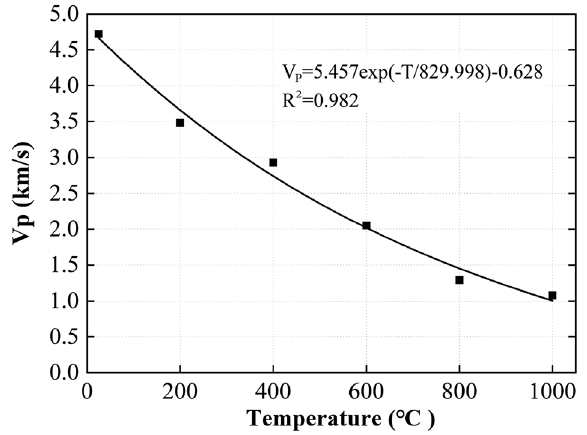
Figure 4. Relationships between P-wave velocity, V p , and maximum treating temperature, T.